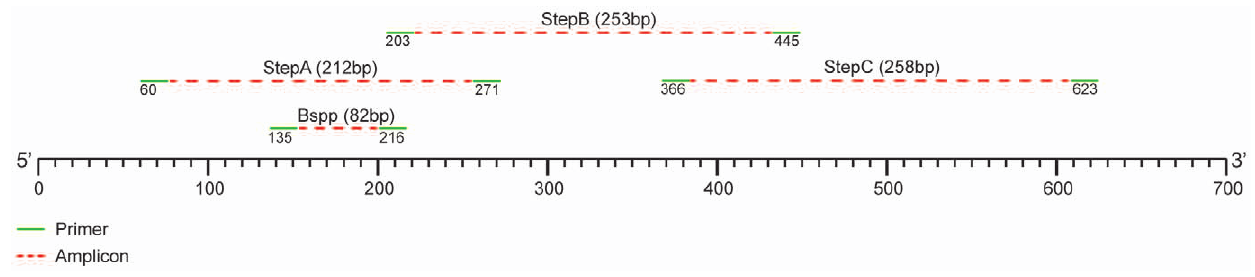
Figure 1. Schematic representation of the relative position of the Brachyspira primers and resultant PCR fragments. Numbering and fragment sizes according to the 16S sequence of the type strain of B. aalborgi (NCTC 11492). Fragment names refer to Table 1.